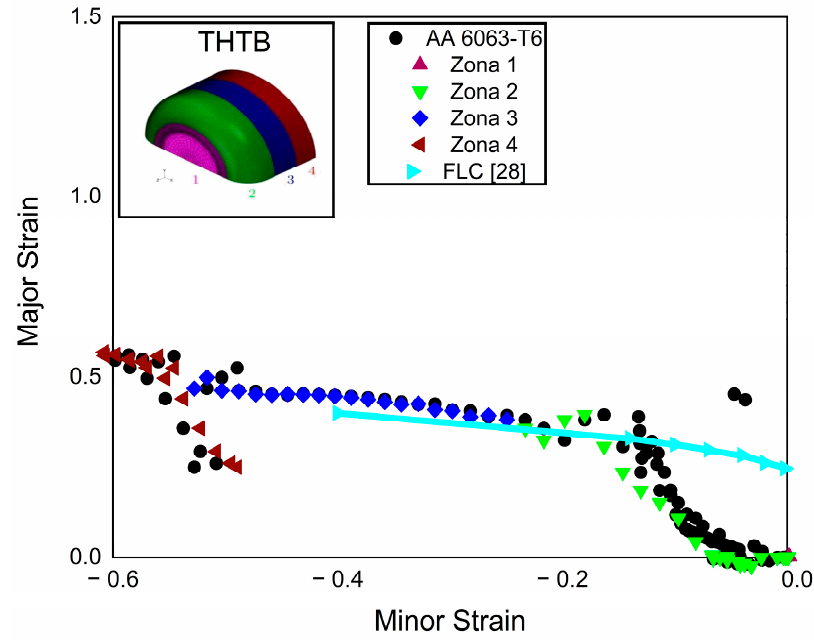
Figure 12. Strain distribution and forming the limit diagram of THTB and conventional AA6063-T6 at a punch displacement of 30 mm and 9 mm, respectively. We added an extrapolated point from the original reference [28] at a minor strain value of 0.4.